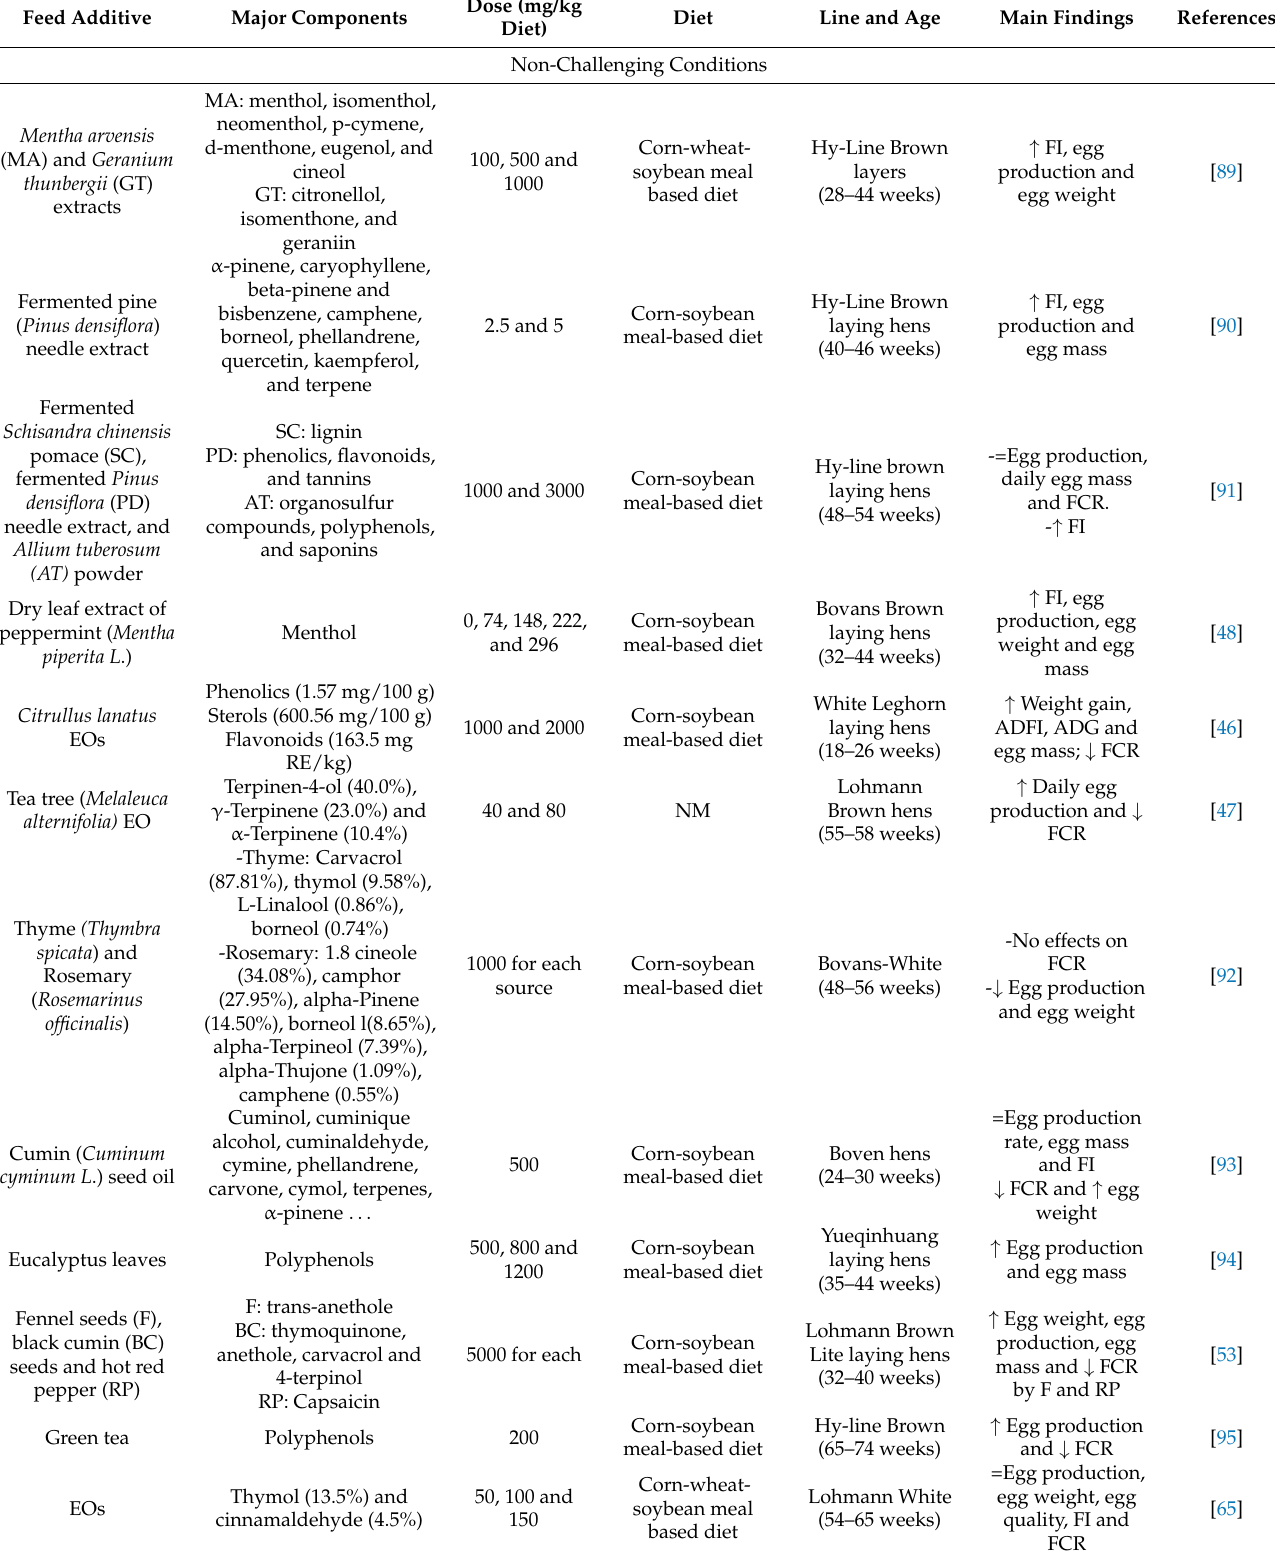
Table 2. Effects of dietary supplementation of PFAs on growth performance of laying